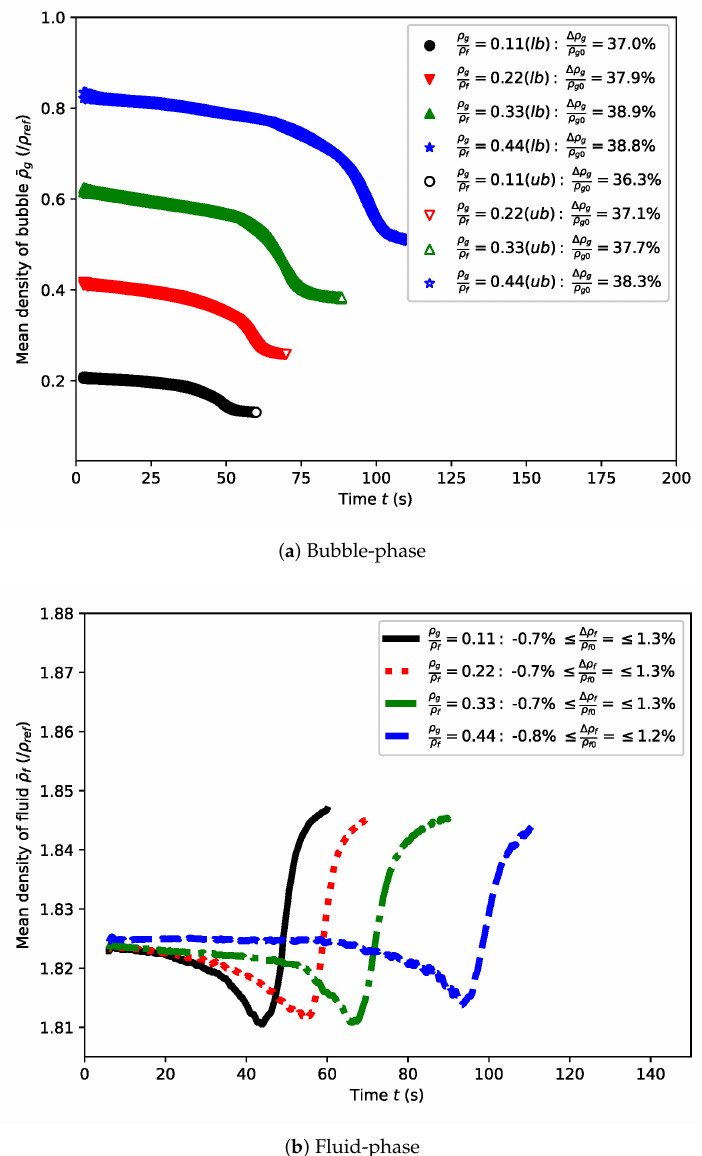
Figure 12. The mean densities ¯ ρ g of the bubble ( a ) and the surrounding fluids ( b ) for different density ratios ρ g = 0.11 − ρ f